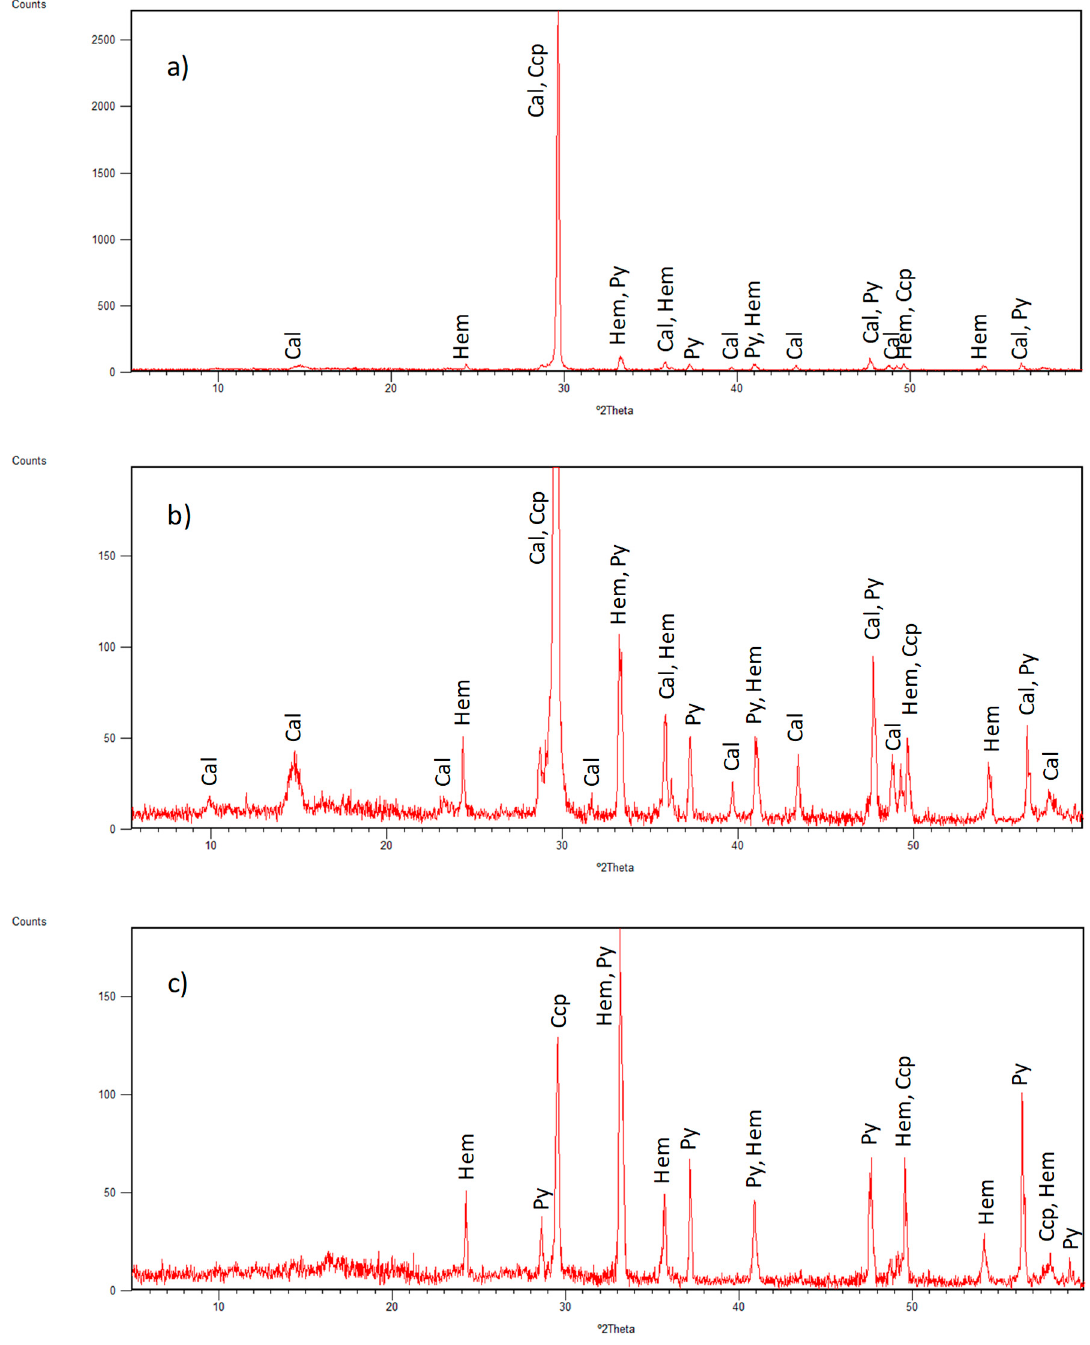
Figure 2. XRD patterns of CS-A before (( a ) original and ( b ) intensity-scale zoom) and ( c ) after treatment with acetate buffer. (For mineral name abbreviations and d-spacing labeled as a plane direction of h k l , see Table 2).